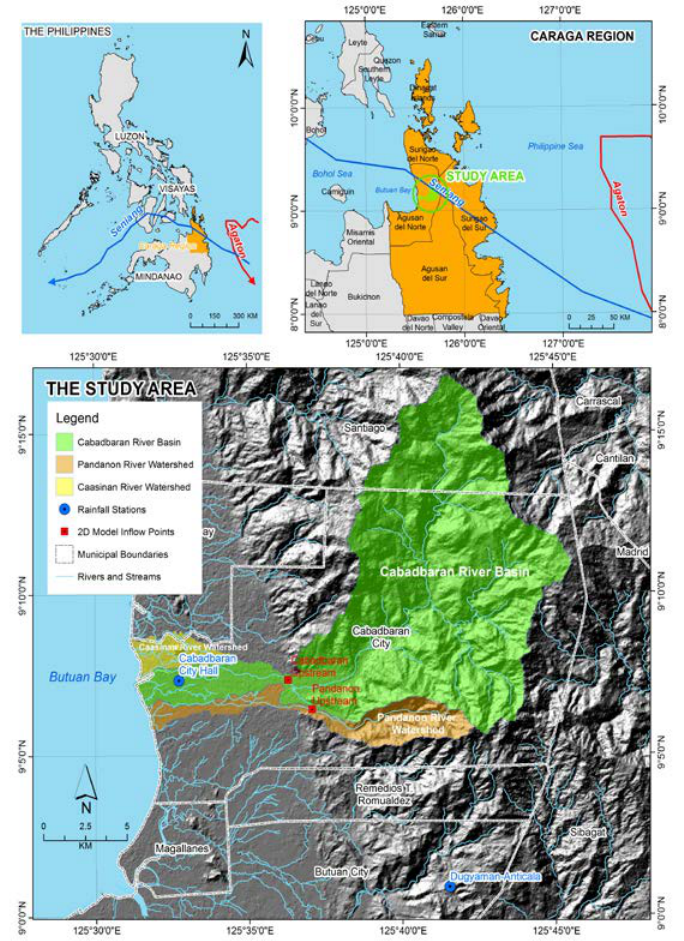
Figure 2. Series of maps showing the study area which consists of Cabadbaran River Basin and the watersheds of Pandanon and Caasinan Rivers in Agusan del Norte, Caraga Region, Mindanao, Philippines, including the track of TS Seniang when it made land fall in December 2014. The track of TS Agaton which affected the country in January 2014 is also shown. The locations of rain gauges whose data was used in the analysis are also